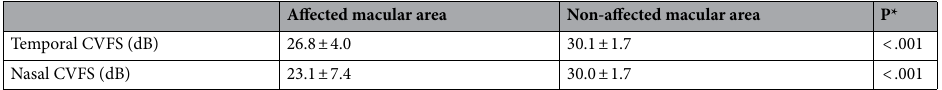
Table 3. Comparison of the mean central visual field sensitivity of the BRVO-affected macular area and the non-affected macular area. Values are presented as means ± standard deviation. CVFS central visual field sensitivity, BRVO branch retinal vein occlusion. *P value by unpaired t